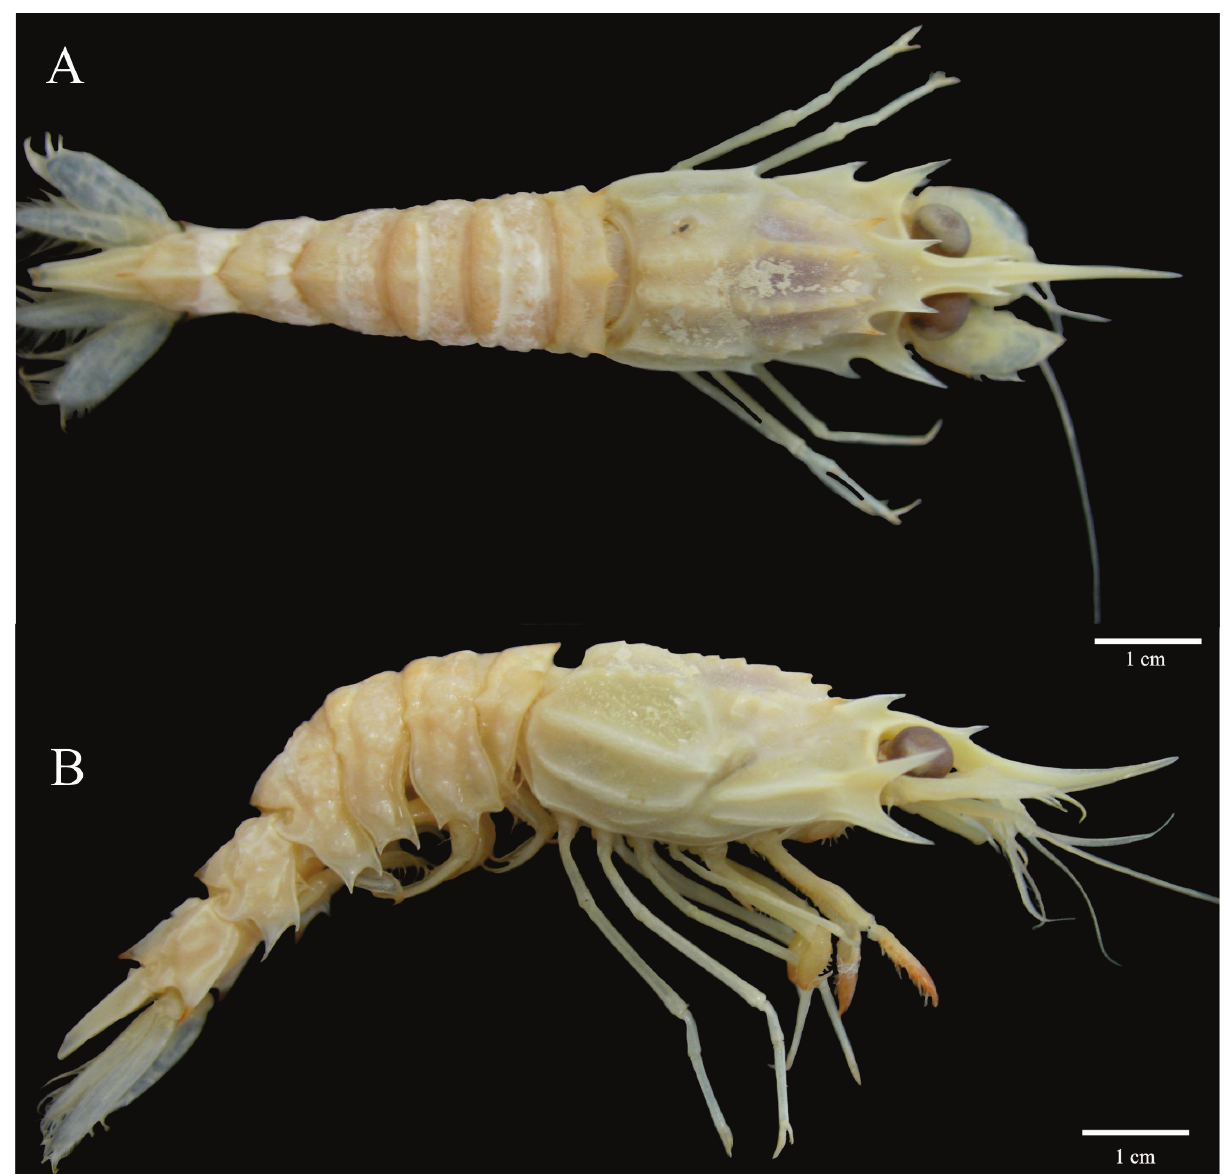
Figure 3. Glyphocrangon alispina Chace, 1939, dorsal (A) and lateral (B) views, male (TL-68.5 mm; Bpot-Talude MT# 75-2; MOUFPE 15.182), northeastern